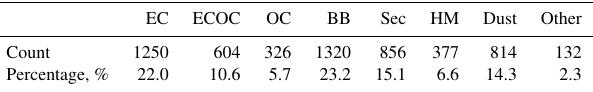
Table 2. The abundance of major particle types in total oxalic-acid- containing particles during the haze episode in winter (8 Febru- ary